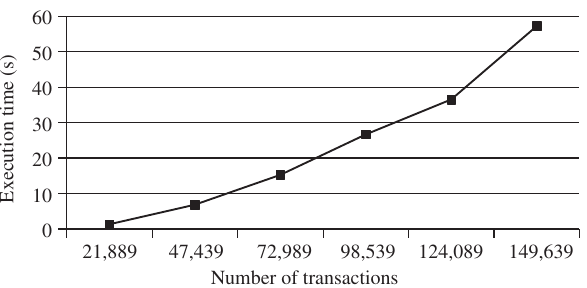
Figure 10. Execution time vs. size of database at minsupp = 0.1, mininterval = 7, maxgap = 10 ( BMS-WebView-1